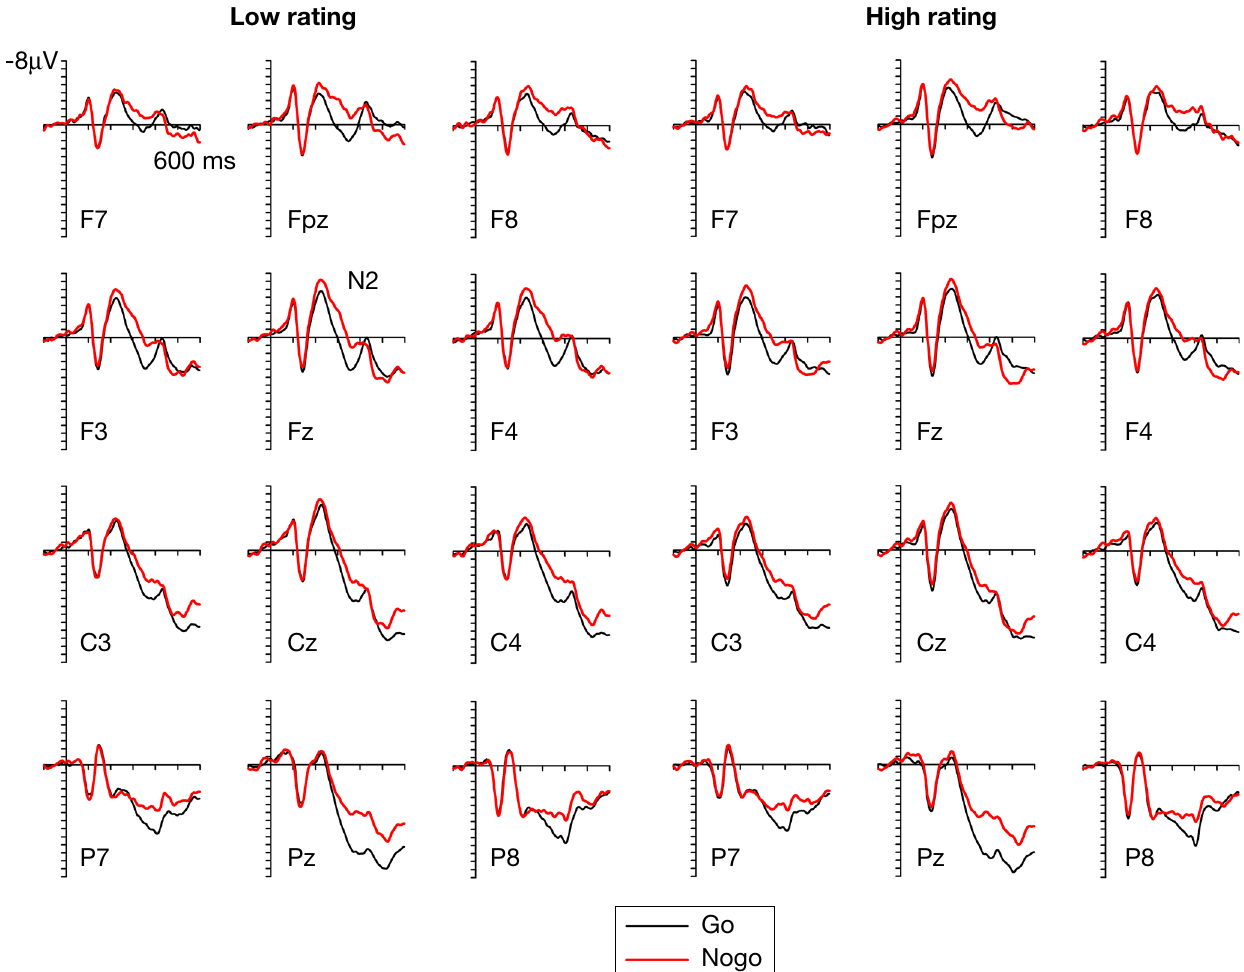
Figure 3 | Grand-averaged ERPs elicited at frontopolar, frontal, central, and parietal electrode sites in Go trials (black line) and Nogo trials (red line) displayed separately for faces that subsequently received a low trustworthiness rating (left panels) and a high trustworthiness rating (right panels). For display purposes only, waveforms were low-pass fi ltered at 40 Hz to remove any residual high-frequency